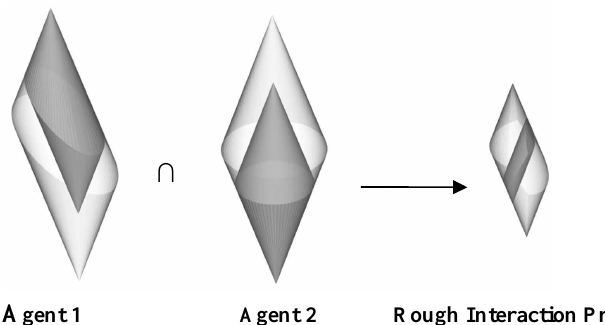
Figure 2. Constructing a rough interaction prism using an intersection